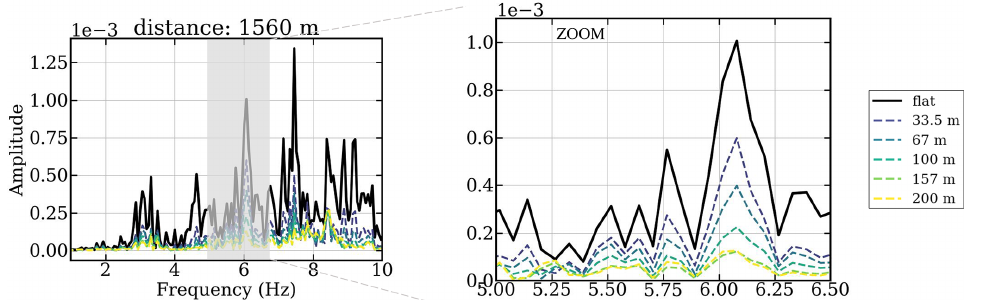
Figure 8. Spectra of the simulation results for the propagation of seismic energy in the presence of topographic variations (see Fig. 7 for the models considered here). The source is placed at the top of the mounds, and the mounds are filled with a scattering medium where the rms velocity is faster than the top layer of the box (zero elevation).